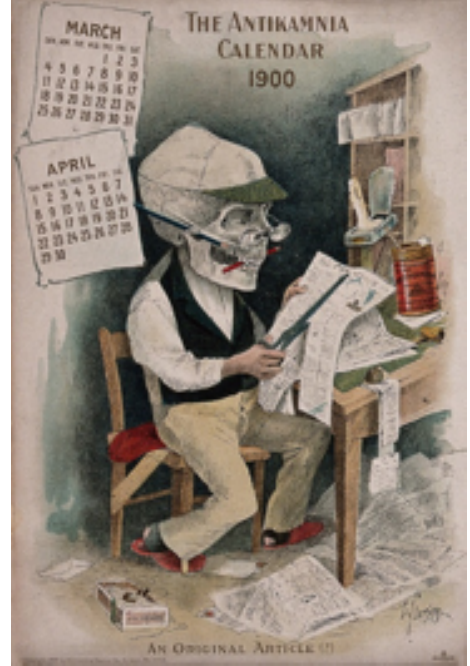
Fig. 4 ‘Scissors and paste’ in the news industry, lithograph by L. Crusius, 1900, Wellcome